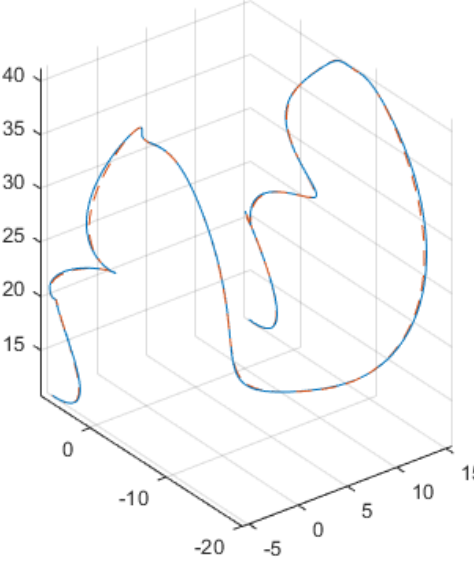
Figure 11. Comparison of expected trajectory and actual trajectory. Figure 12. Comparison of expected trajectory and actual trajectory.